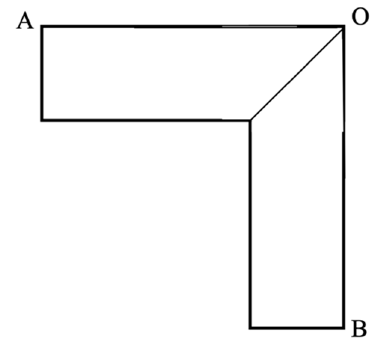
Figure 5. The plane projection of half tube.